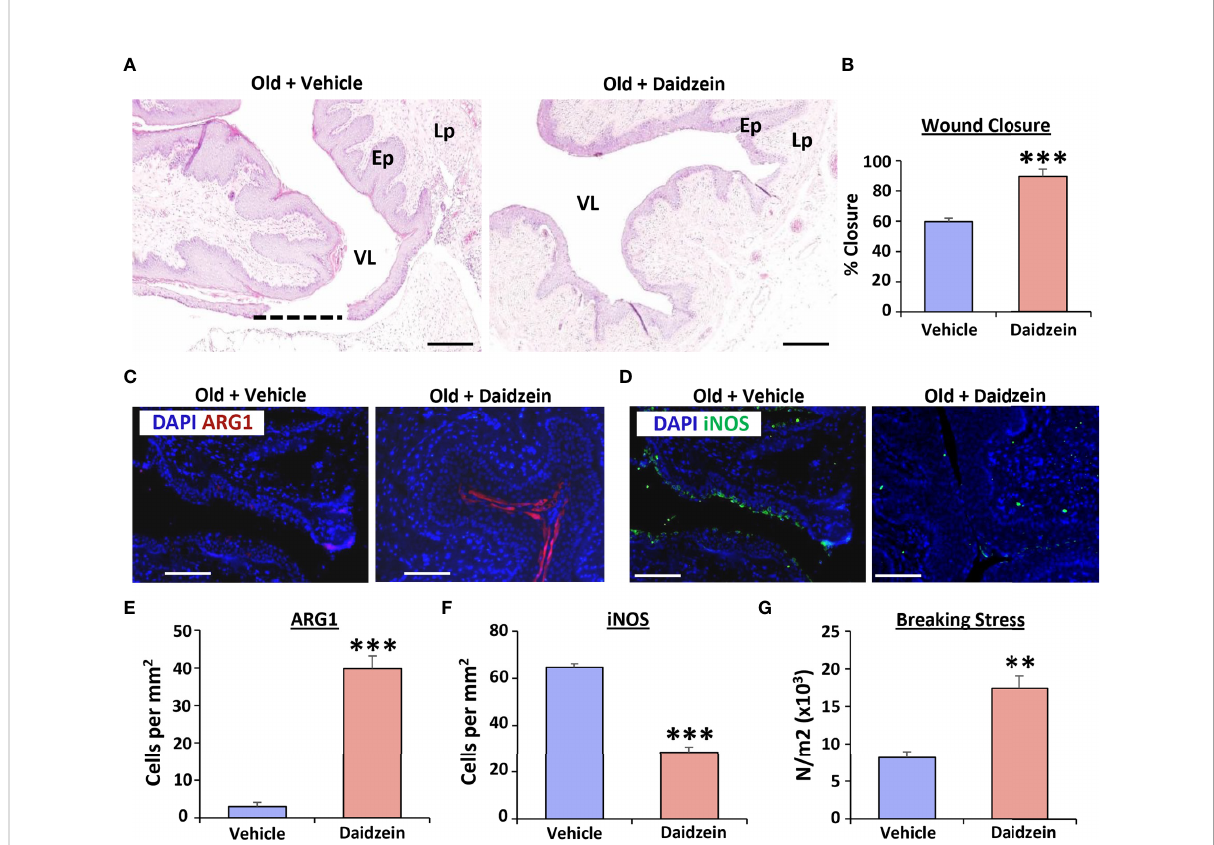
FIGURE 5 Daidzein activates Arginase I and restores vaginal repair in aged rats. Haematoxylin and eosin staining showing vaginal healing differences between vehicle and daidzein treated aged rats (A) , with quanti fi cation of wound closure in (B) VL = vaginal lumen, Ep = epithelium, Lp = lamina propria. Dotted line = open wound area. Bar = 500 m m. Arginase 1 (Arg1; C ) and iNOS (D) staining of vaginal epithelium with quanti fi cation (E, F) . Arg1 = Alexa Fluor 594. iNOS = Alexa Fluor 488. DAPI = nuclei. Bar = 200 µm. n=6 rats per group. Vaginal tissue breaking stress, assessed 30 days following injury (G) . n = 3 rats per group. Mean +/- SEM. Independent t tests performed. **= P < 0.01 and ***= P <